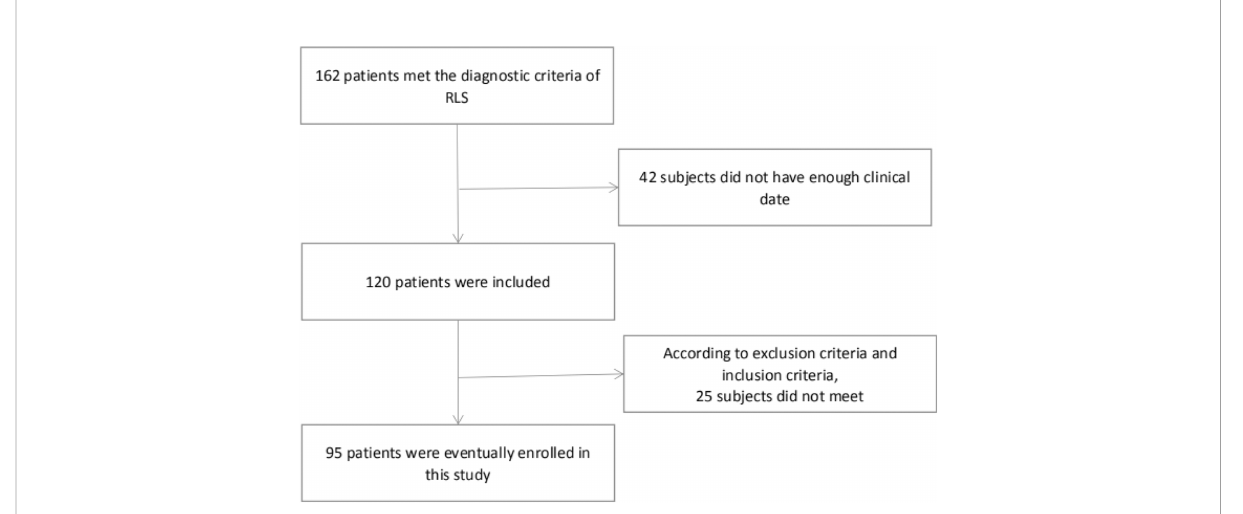
FIGURE 1 Flow chart of patient